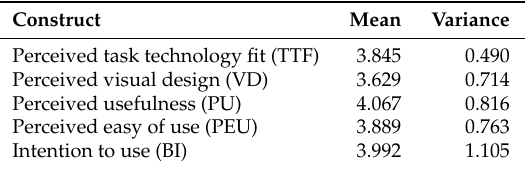
Table 6. Means and variances of constructs.